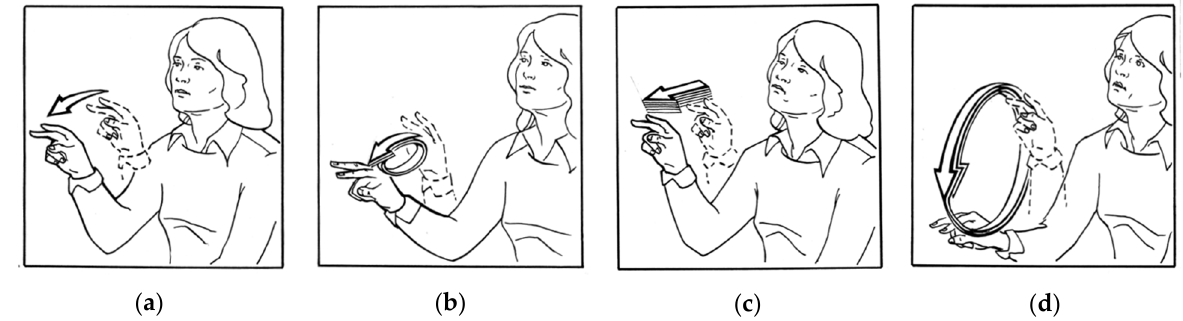
Figure 2. Temporal aspects in American Sign Language (Klima and Bellugi 1979) ( a ) LOOK (citation form), ( b ) LOOK Habitual, ( c ) LOOK Durational, ( d ) LOOK Continuative. (With permission from Urusula Bellugi).